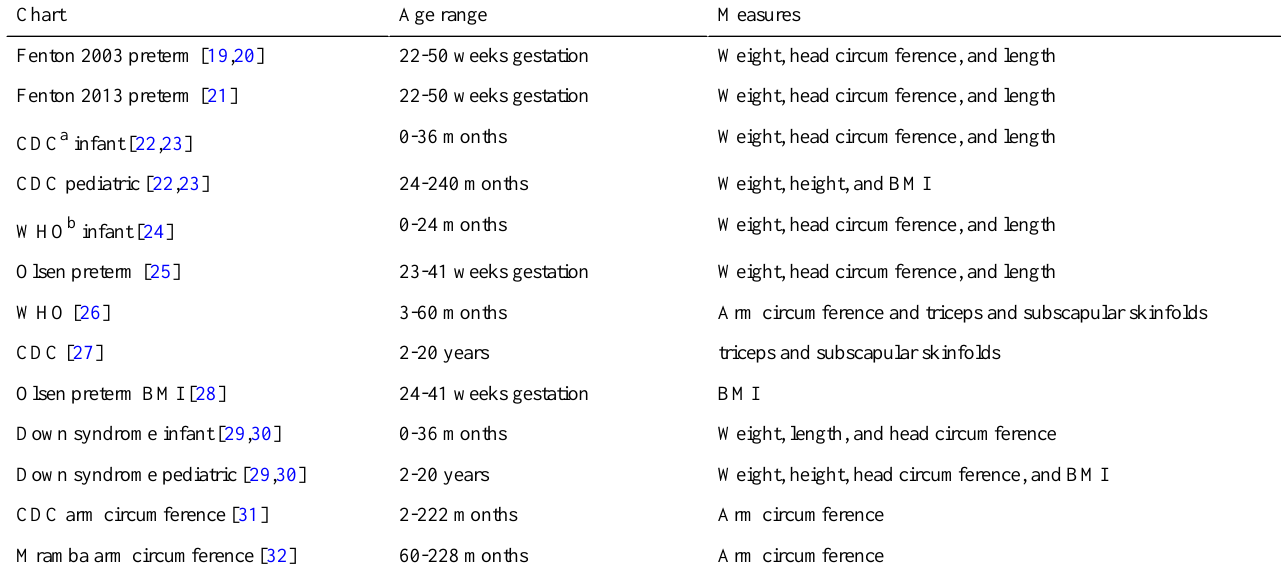
Table 1. Anthropometric growth calculators implemented on PediTools and sources of lambda-mu-sigma parameters. MeasuresAge rangeChart